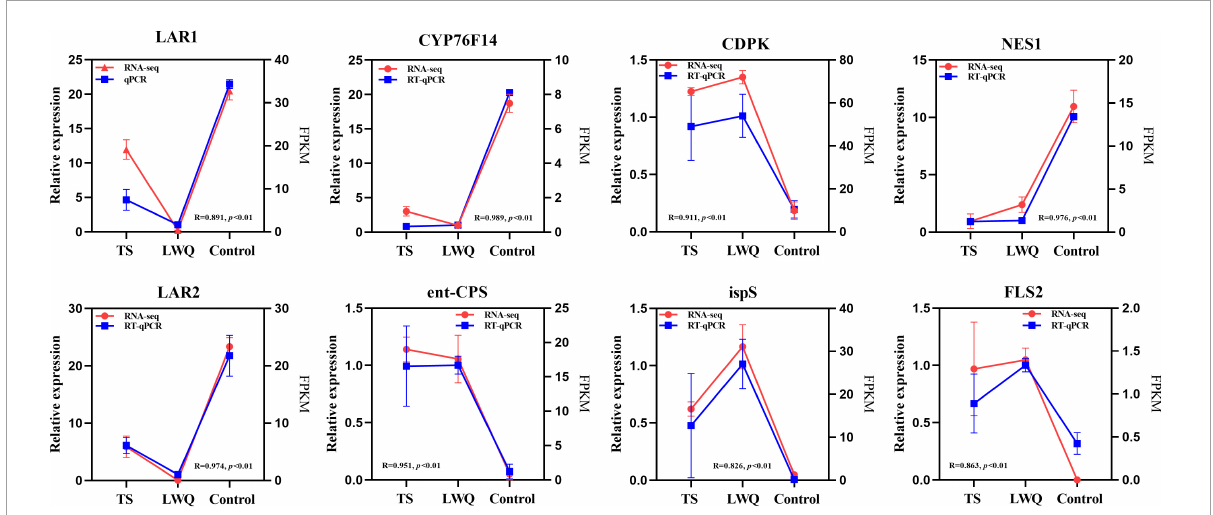
FIGURE6 Validation of RNA-seq data by RT-qPCR. R was the correlation coefficient between the FPKM value of RNA-seq and the relative expression level of RT-qPCR, and p was the significance between the FPKM value of RNA-seq and the relative expression level of RT-qPCR. p < 0.01 means a significant correlation at the 0.01